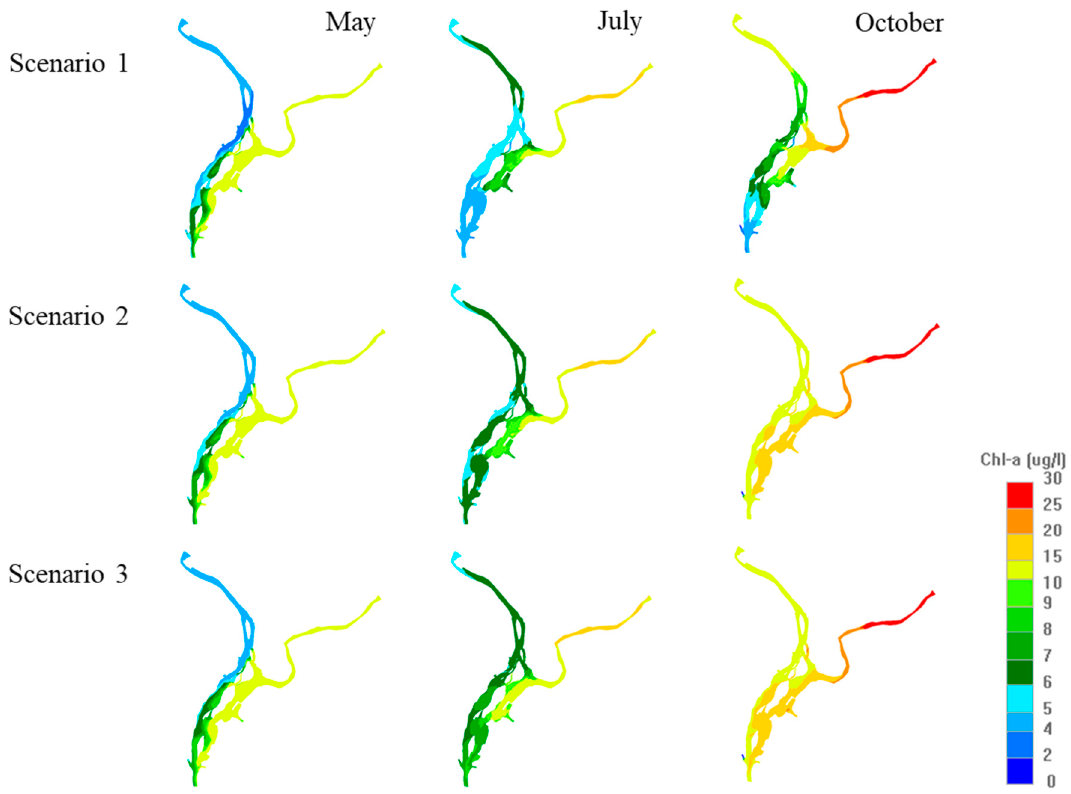
Figure 9. Sensitivity analysis results of seasonal Chl-a concentration.